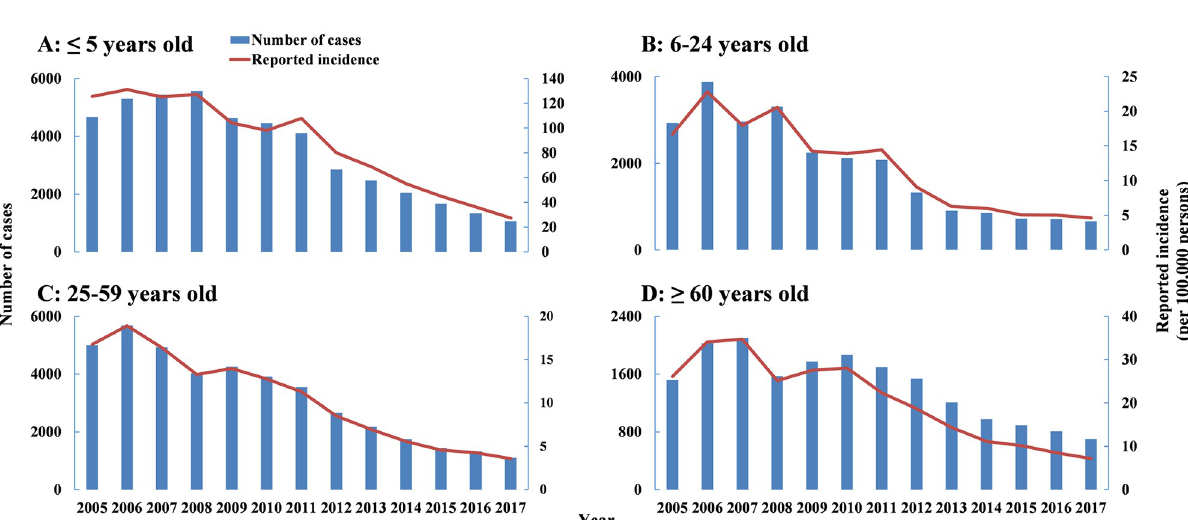
(Fig 4). The incidence in all age groups decreased from 2005 to 2017.